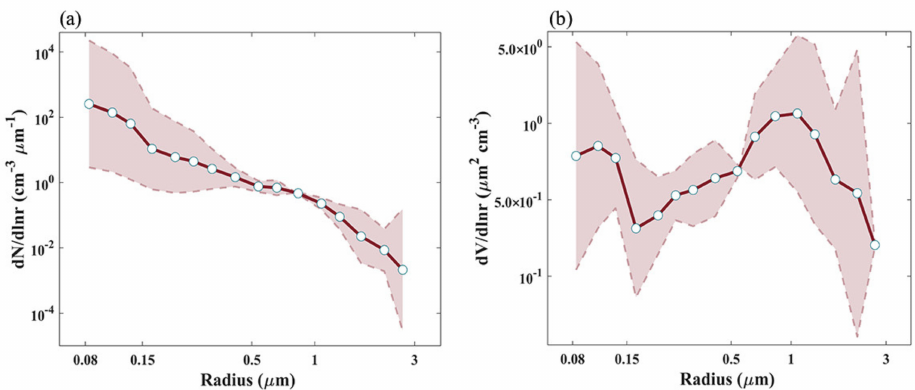
Figure 4. Particle size ( a ) number and ( b ) volume concentration distribution measured during the experiment from 8 June to 2 July 2019. Blue hollow dots represent the average number concentration at different radii. The pink area represents the standard